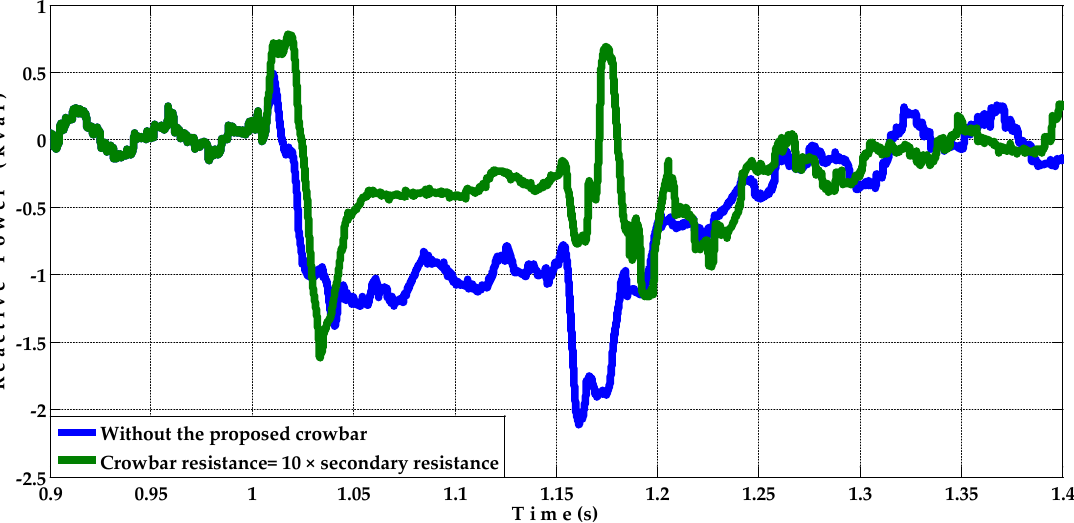
Figure 14. Active power of BDFRG with and without the proposed crowbar under single-line to ground fault occurrence.